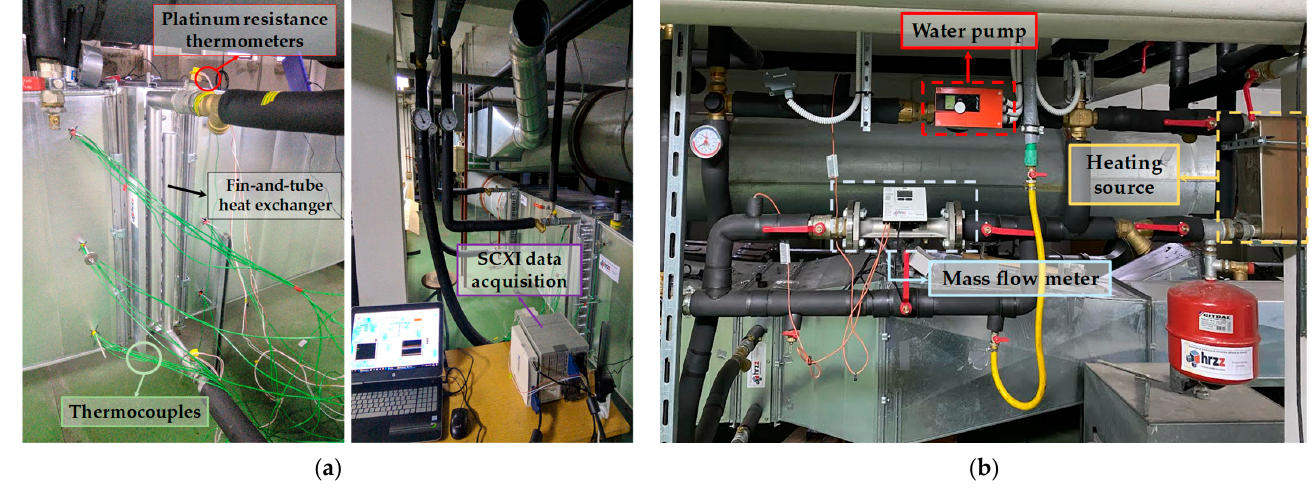
Figure 9. Segment of the measurement setup, ( a ) the test section with measurement sensors and data acquisition and ( b ) closed water loop with regulation.